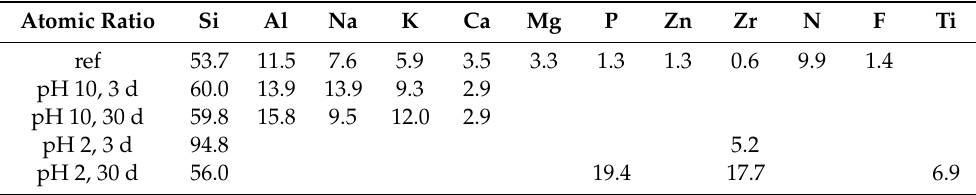
Table 2. The surface composition (atomic %) of reference, corroded disks in pH 10 and pH 2 for 3 days and 30 days of constant